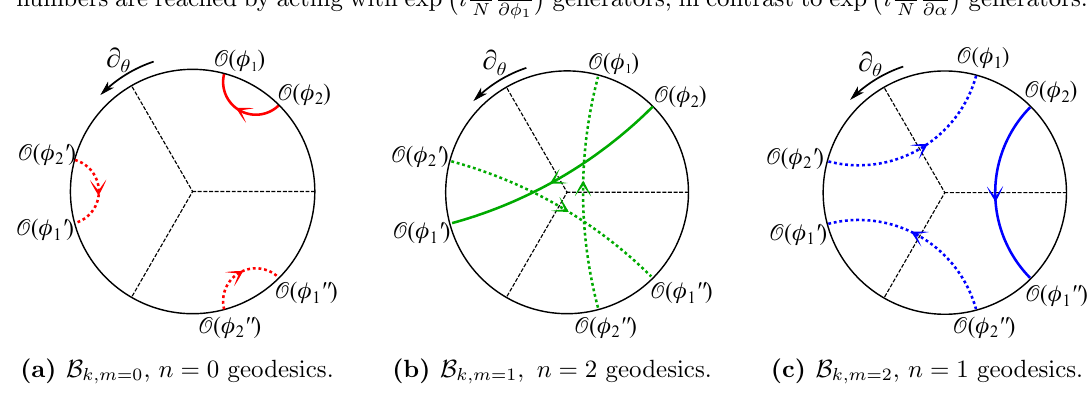
Figure 4 . On kinematic space, (cid:30) 1 is a null coordinate. In terms of cover operators, acting with (cid:0) (cid:1) @ exp i 2 (cid:25) increases the angular separation (cid:11) . In terms of conical defect geodesics, acting once N @(cid:30) 1 (cid:0) (cid:1) @ with exp i 2 (cid:25) increases the winding number while leaving the endpoints (cid:12)xed. All winding N @(cid:30) 1